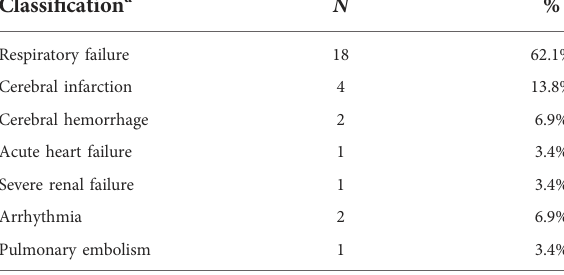
TABLE 3 Reasons for postoperative unplanned ICU admission.